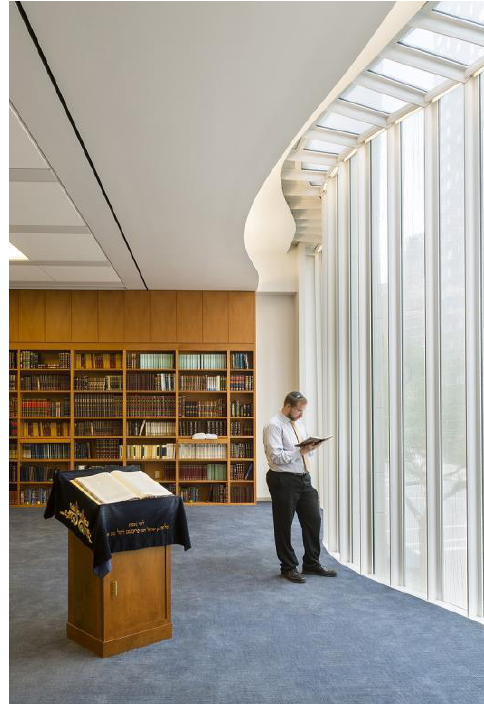
Figure 10. Beit Midrash, detail. Western glass wall. Photo David Sundberg/ESTO.